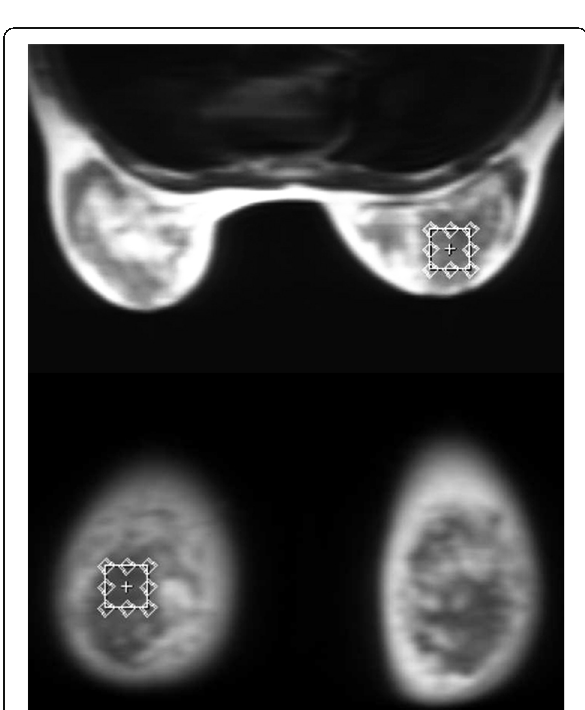
Fig. 1 Placement of the volume of interest for spectrum acquisition into the most homogeneous part of the